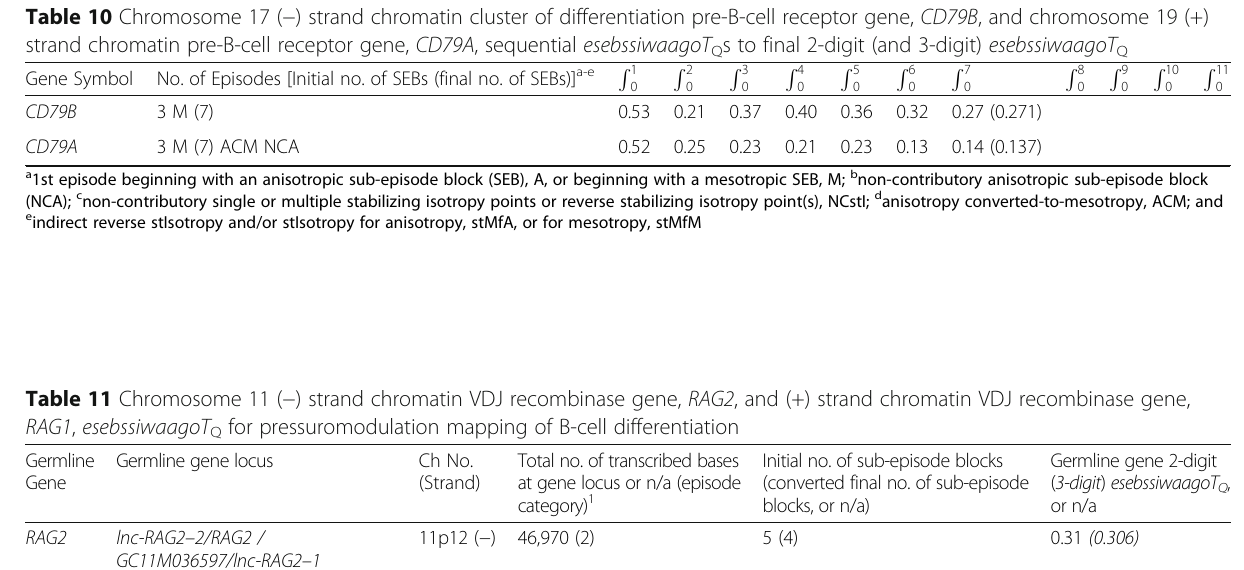
R R R 1 2 3 0 0 0